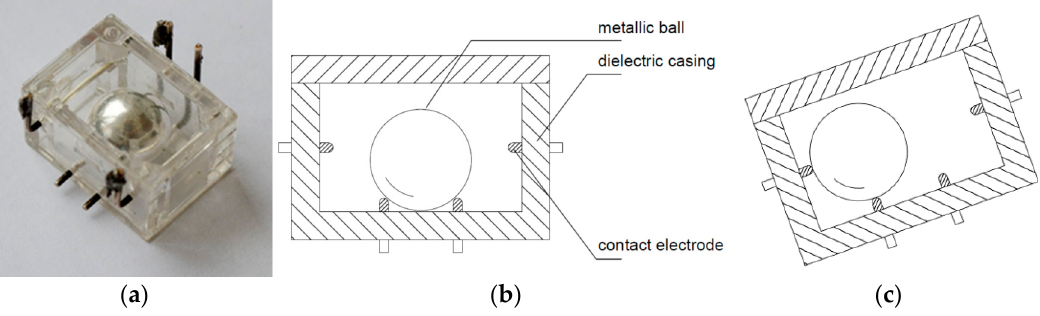
Figure 2. Single-axis tilt switch: ( a ) photograph; ( b ) general diagram; ( c ) principle of operation.